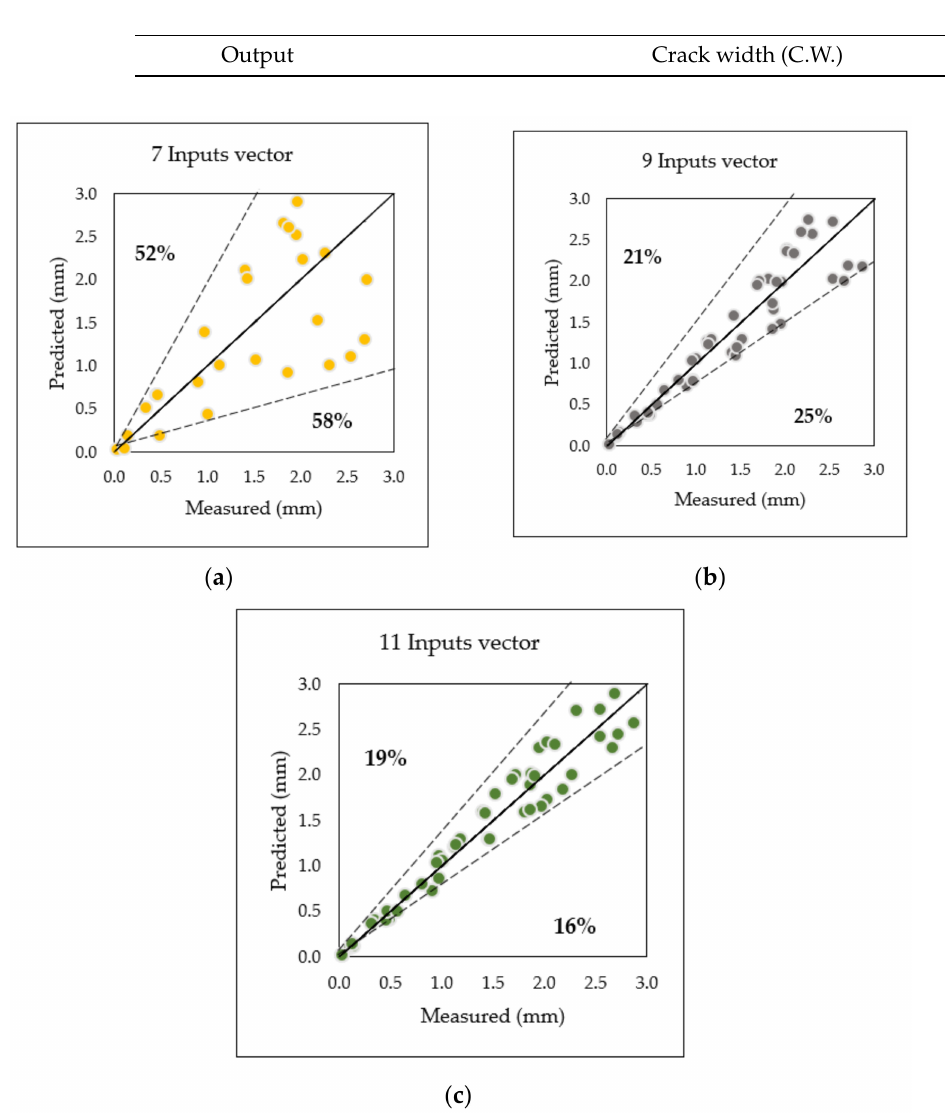
Figure 12. The distribution of predicted results are dependent on inputs vector: ( a ) Seven inputs vector, ( b ) nine inputs vector, and ( c ) eleven inputs